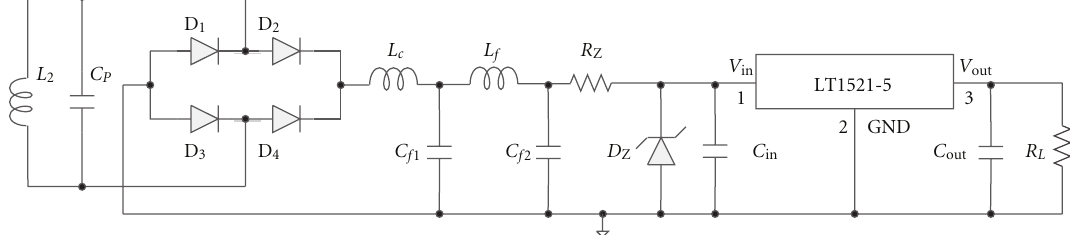
Figure 4: Schematic diagram of the inductive powering secondary unit of the system.